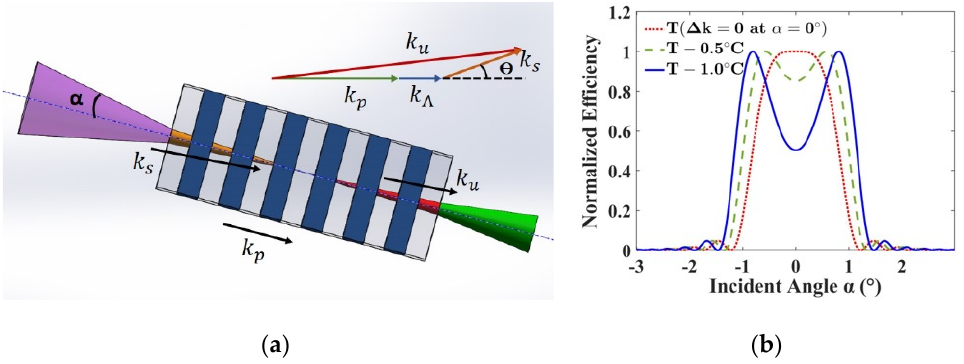
Figure 1. ( a ) Schematic diagram of noncollinear phase-matching in PPLN. ( b ) Comparison of normalized efficiencies with respect to incident angles in three different cases.